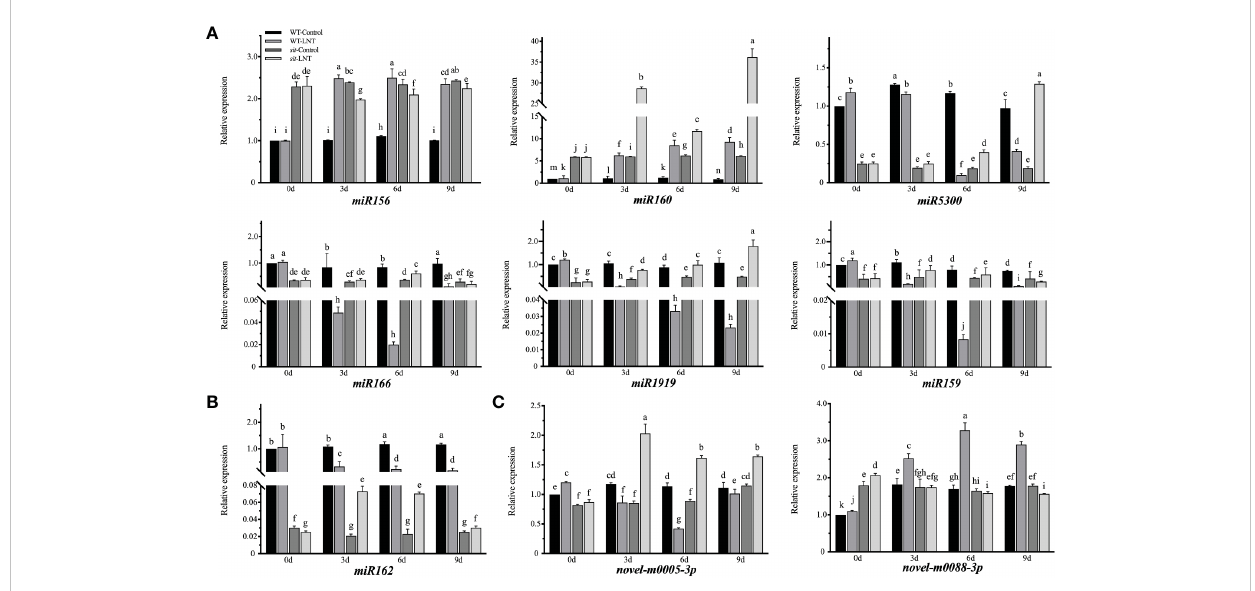
FIGURE 3 Mature miRNA changes in response to LNT stress with the ABA-dspendsnt signaling pathway in tomato. (A) Relative expression of known miRNAS ( miR156, miR160, miR5300, mIR166, mIR1919, and miR159 ) in succession of LNT treatment. (B) Relative expression of miR162 as the candidate miRNA. (C) Relative expression of new mIRNAS ( novel-m0005-3p and novel-m0082-3p ) in succession of LNT treatment. d, Days of LNT treatment (0, 3, 6, and 9 days). Control: 25 °C/15 °C, LNT stress: 25 °C/6 °C (daylight temperature). Data are means and standard error of four independent experiments (n = 4). Lowercase letters indicate signi fi cant differences at P < 0.05 according to Tukey's